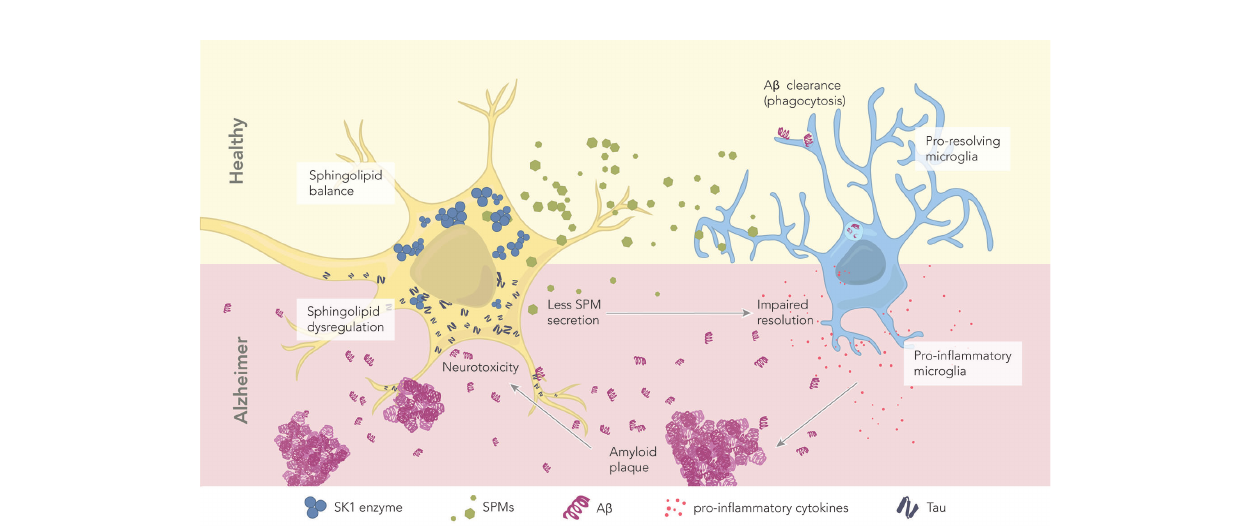
FIGURE 3 | The role of sphingolipids and specialized pro-resolving mediators in health and disease. In healthy conditions, neurons maintain a proper balance of sphingolipids. The abundant SK1 enzyme deviates the sphingolipid pathway toward SPM production and secretion. Secreted SPMs reach perineuronal microglia, promoting their pro-resolving phenotype. Pro-resolving microglia maintain a healthy microenvironment by clearing amyloid beta through phagocytosis. In AD, there is a dysregulation of sphingolipids and SPMs, which correlates with the levels of hyperphosphorylated tau and A b . Reduced levels of the enzyme SK1 result in less SPM production and secretion. Microglia become pro-in fl ammatory, and start secreting pro-in fl ammatory cytokines. A b is no longer cleared, leading to the formation of extracellular amyloid plaques. These plaques further contribute to